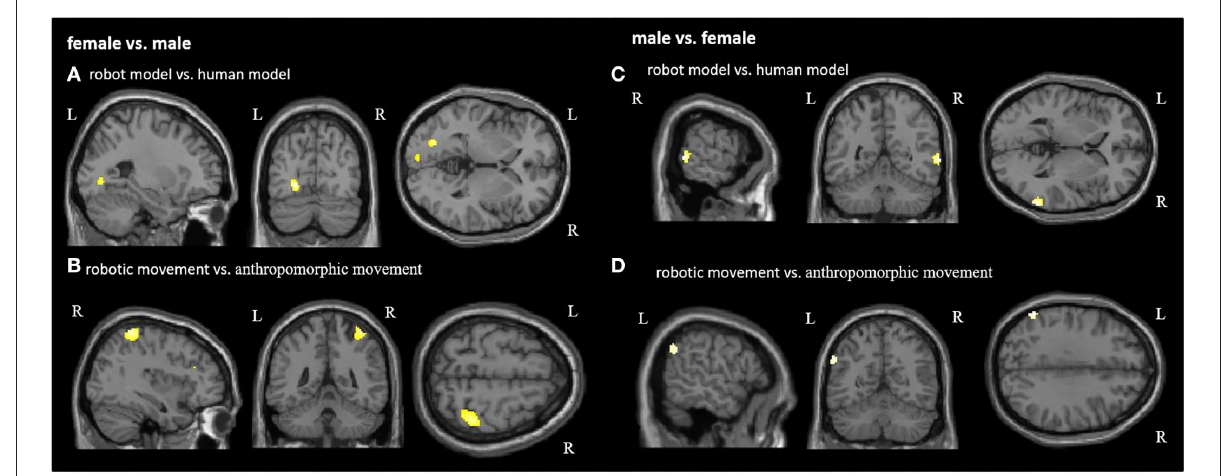
FIGURE5 Group comparison between female and male participants in each condition. Significant activations for female participants in the contrast (A) robot model vs. human model and (B) robotic movement vs. anthropomorphic movement. Significant activations for male participants in the contrast (C) robot model vs. human model and (D) robotic movement vs. anthropomorphic movement. R, right hemisphere; L, left hemisphere (for visualization purposes, a threshold uncorrected p < 0.001, k = 10, was applied).